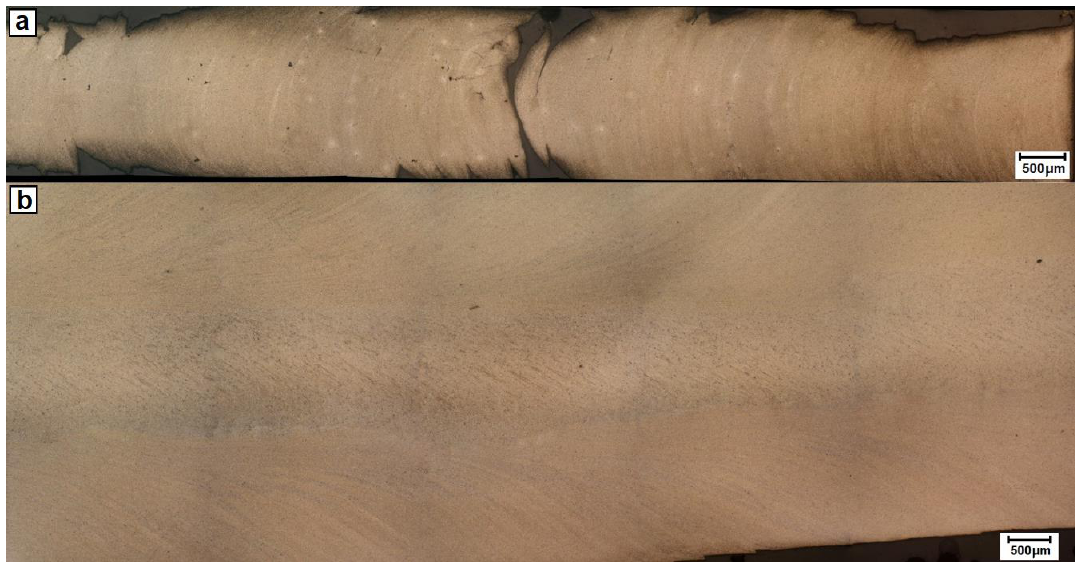
Figure 7. LM images of longitudinal section of E/224 rpm cut at: ( a ) ~0.2 mm from surface and ( b ) through its center.